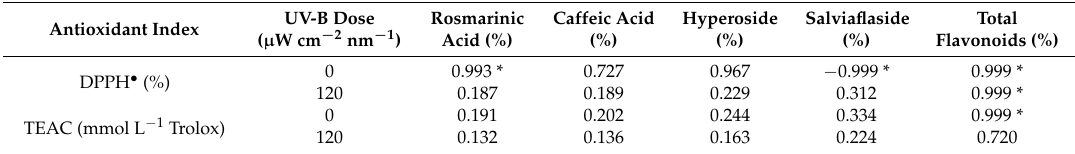
Table 2. Correlation analysis between the contents of the bioactive compounds and the DPPH • and ABTS • + radical scavenging activities of the ethanol extracts of P. vulgaris spicas at three developmental stages of under the control and UV-B